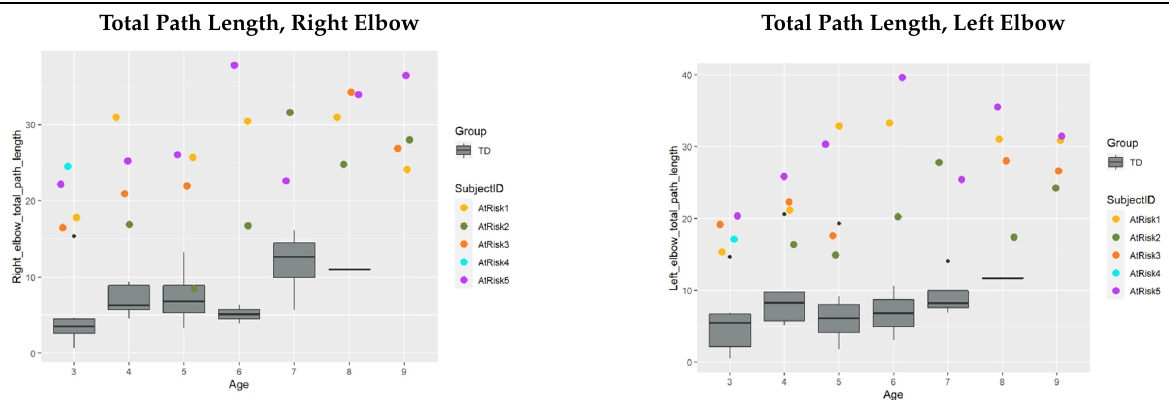
Table 3. Comparison of HUGS ‐ 2 (at ‐ risk) and HUGS ‐ 1 (TD) infants’ movement. Total Path Length, Right Elbow